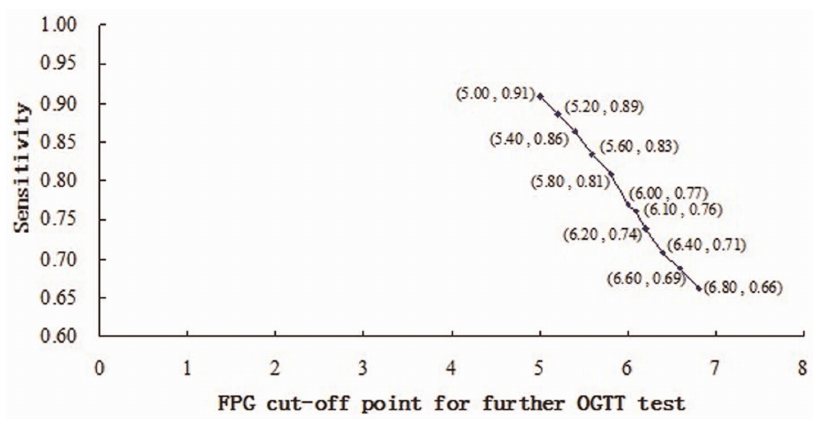
Figure 2. Sensitivity for each screening strategy of FPG test combined with further.